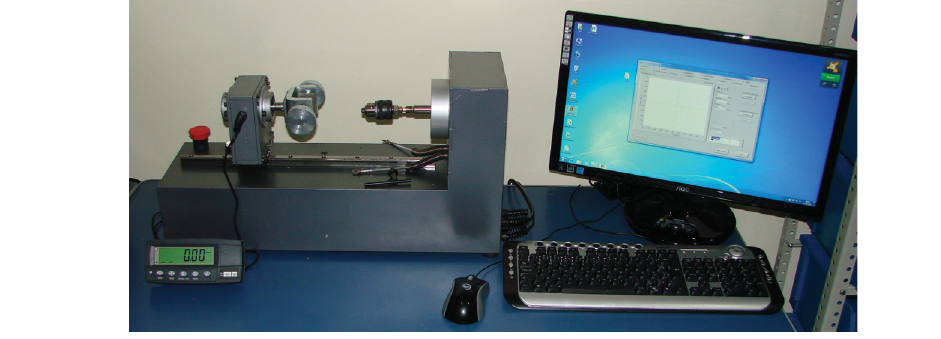
Figure 2. Image of the computer-aided torque test machine used for the